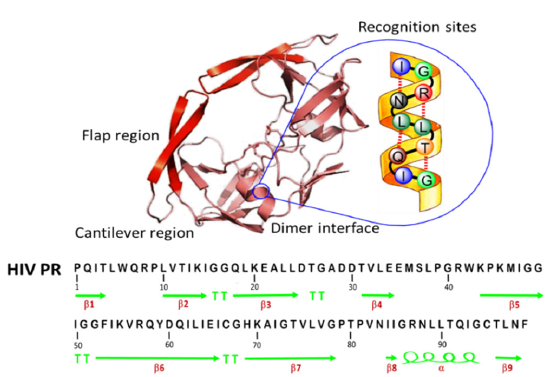
Figure 1. Crystal structures of HIV protease (HIV PR). HIV PR is a homodimer and contains mainly β -sheet and one α -helix per monomer. The one subunit of the monomer is shown in red and pink. The helical peptide epitope structure was selected from the α -helix structure of the HIV PR (yellow).